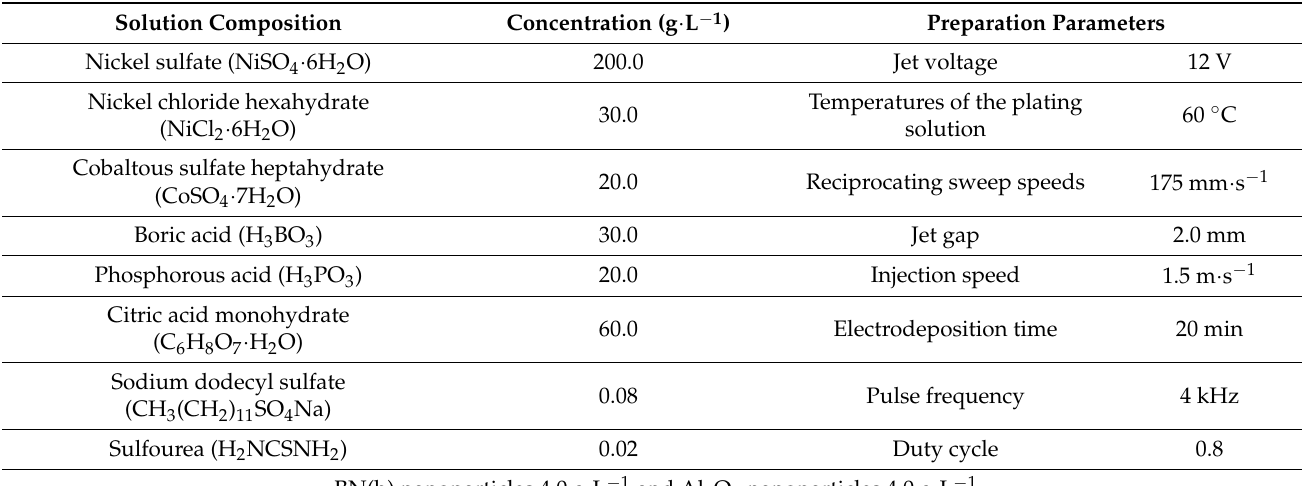
Table 2. Solution composition and preparation parameters used for the coatings